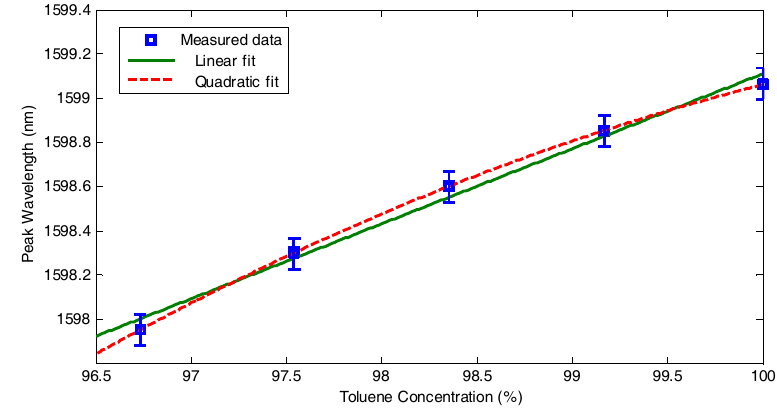
Figure 11. The position of the maxima wavelength versus the toluene concentration in the toluene-acetone mixture.